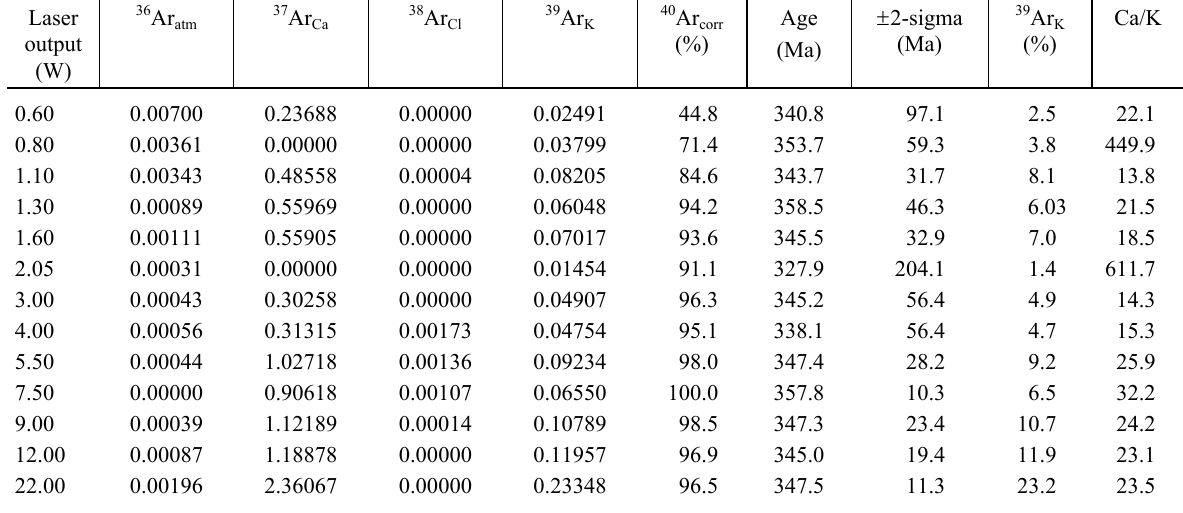
Table 2. 40 Ar/ 39 Ar data of step-heating dating of groundmass plagioclase from dolerite sample D1-1 1/84 (Vrije Universiteit,